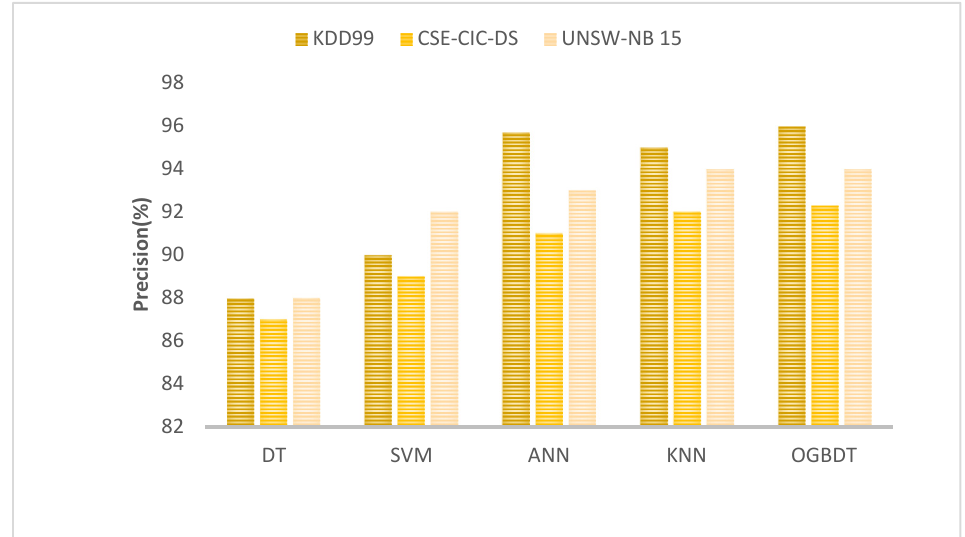
Figure 4. Precision rate comparison.